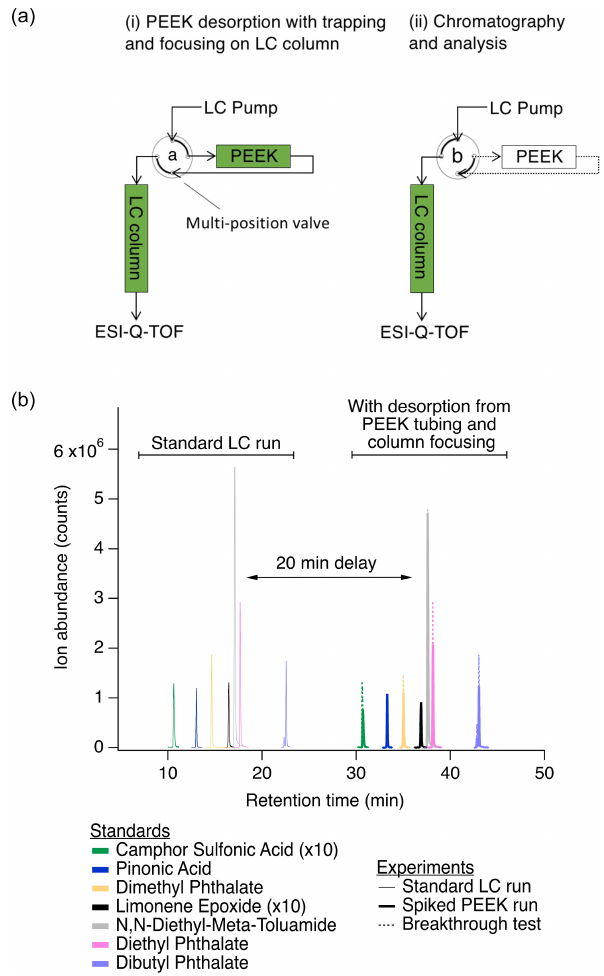
Figure 1. (a) Simplified analytical system setup for functionalized gas-phase compounds, showing (i) desorption from the PEEK col- lector and trapping on the LC column in order to focus analytes prior to chromatographic separation and (ii) subsequent chromato- graphic separation and analysis (discussed in detail in Sect. S1). Green shading indicates active solvent flow through the PEEK col- lector and/or LC column. A multi-position valve was switched from position “a” (panel a .i) to position “b” (panel a .ii) to remove the PEEK collector from the flow path for chromatography and anal- ysis. Table S1 describes the flow rates and solvents used in each of these steps. (b) Comparison of selected peaks from a typical LC run (solid traces from 10 to 23min) to that from a PEEK collector spiked with a standard (bold traces from 30 to 43min) demonstrates desorption, trapping/focusing, and similar chromatog- raphy. Comparable results from a 2h breakthrough test at 2 ◦ C with 22mLmin − 1 air flow are also shown (overlayed dotted traces from 30 to 43min). Spiked PEEK and breakthrough tests were performed to validate these sampling and analysis methods and are discussed further in Sect. S1. Test analytes were used across a range of func- tionalities, with examples shown here and the full list in Table